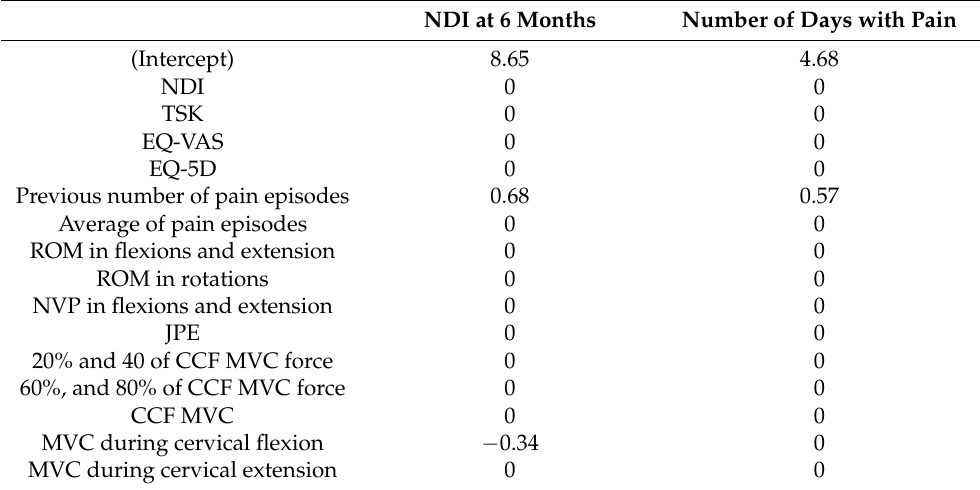
Table 6. Selected predictor variables for response variable of number of days with